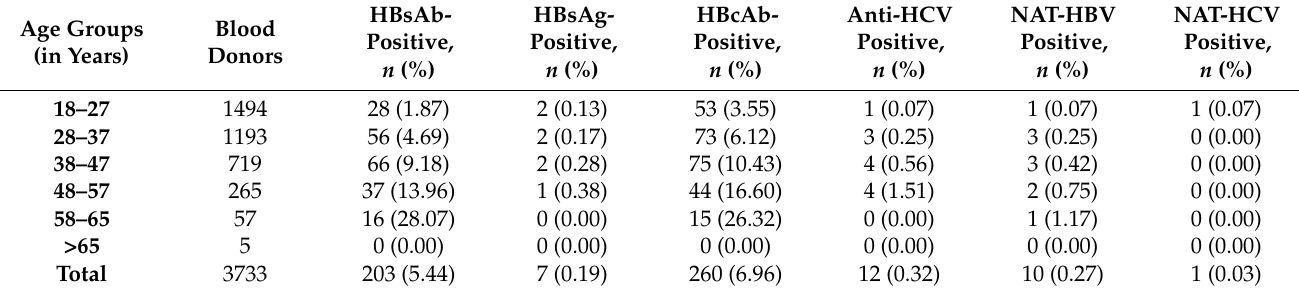
Table 5. Distribution of serologically and NAT positive donors corresponding to their ABO/Rh blood groups. ABO/Rh Blood